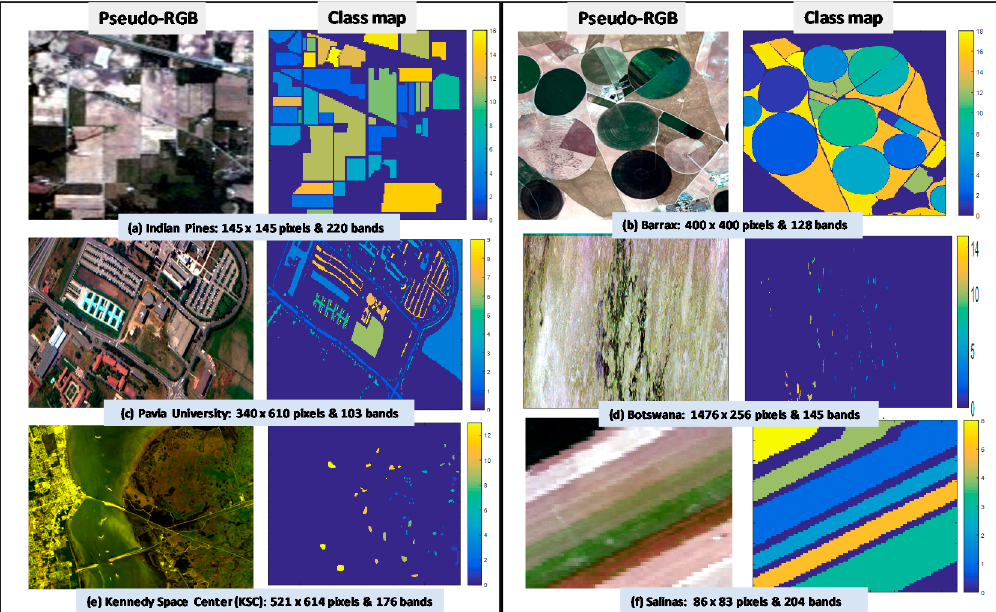
Figure 1. Shows the pseudo-RGB images (in the first and third columns) and their corresponding ground truth (GT) classification maps (in the second and fourth columns) for all the datasets utilized in this study: ( a ) Indian Pines, ( b ) Barrax, ( c ) Pavia University, ( d ) Botswana, ( e ) Kennedy Space Center (KSC) and ( f ) Salinas. Note that neither the dataset nor the GT has been modified such that the results presented in this work can be compared directly with those reported in the